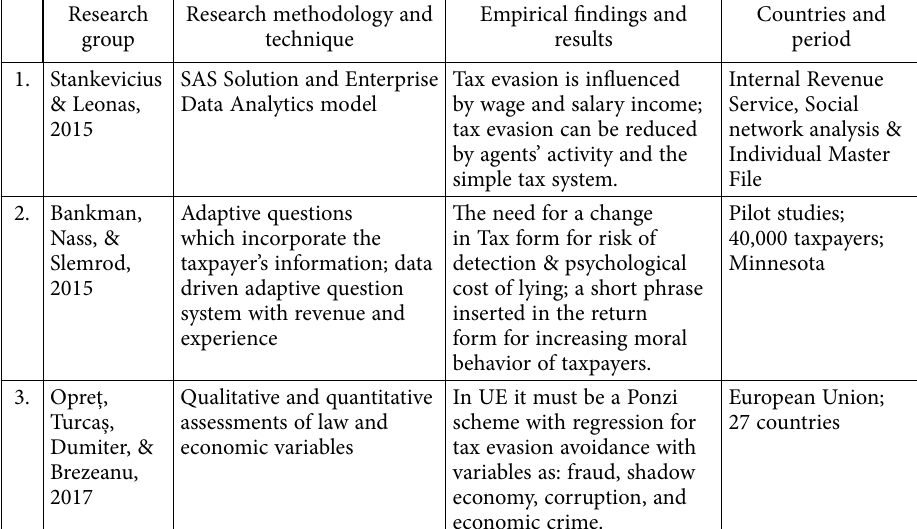
Table 3. Previous empirical studies regarding tax evasion (source: own